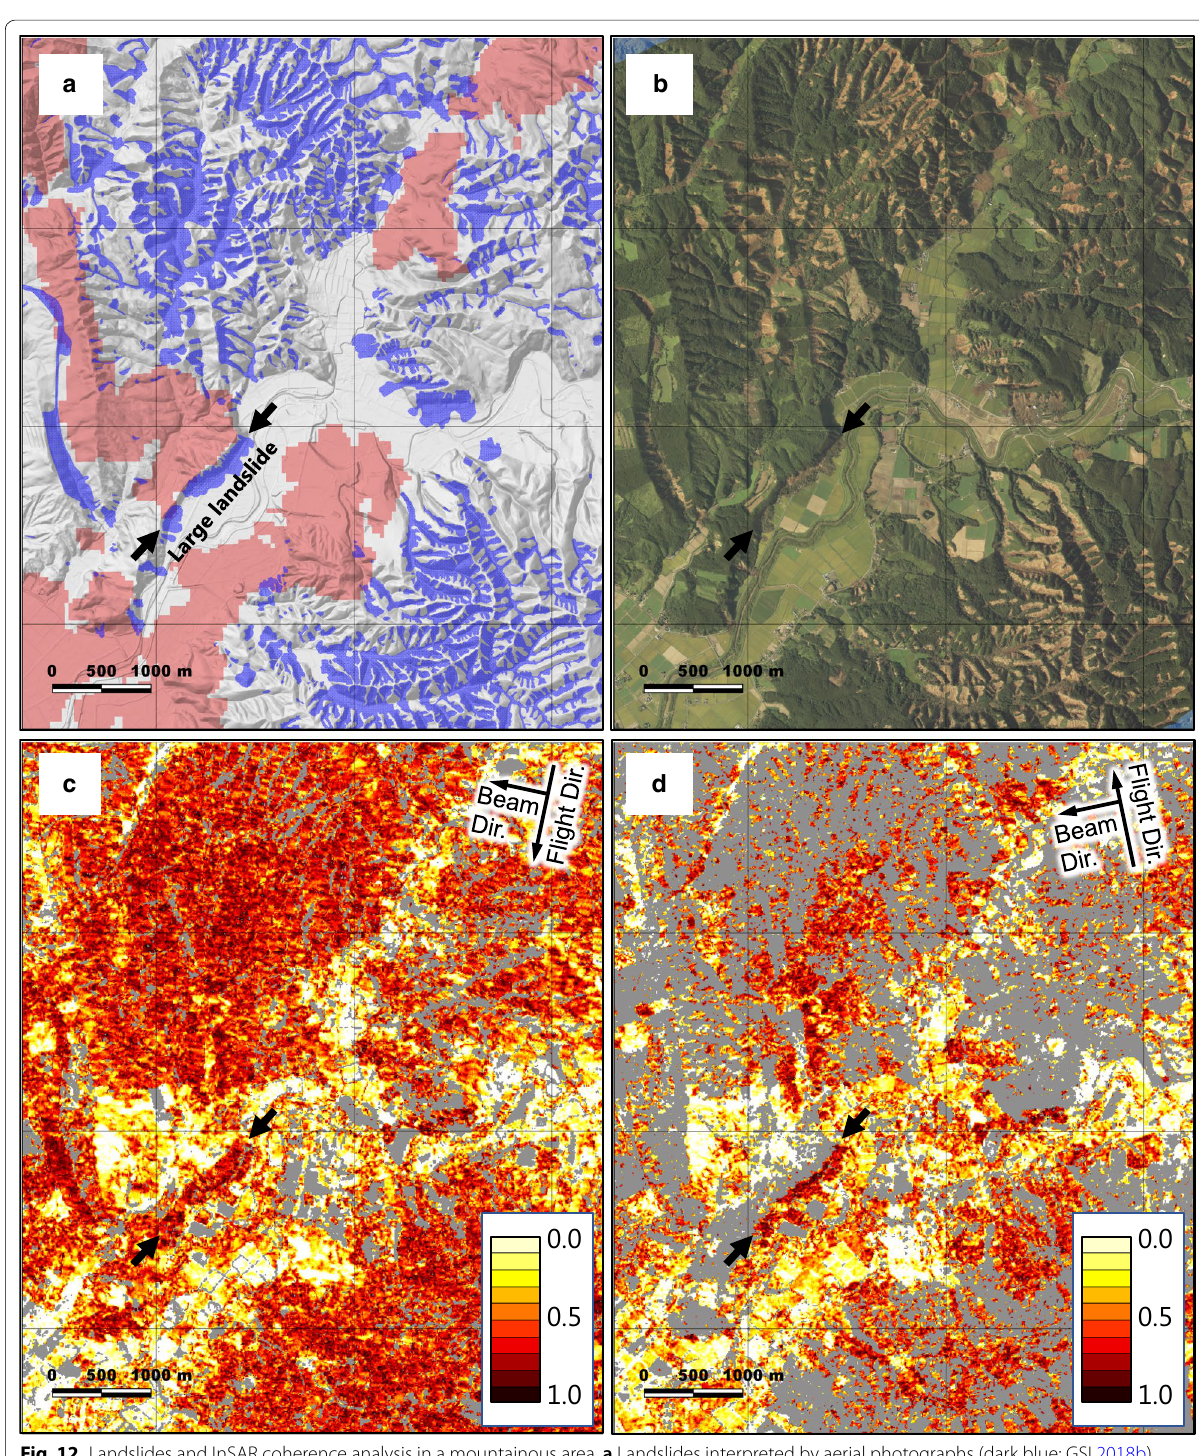
Fig. 12 Landslides and InSAR coherence analysis in a mountainous area. a Landslides interpreted by aerial photographs (dark blue; GSI 2018b) on shaded relief map; location shown in Fig. 11. Pink indicates areas where the normalized phase noise deviation was small enough for the phase unwrapping in Figs. 5 and 6. Black arrows indicated the location of a large landslide that caused the collapse of many houses. b Aerial photograph from after the earthquake. Black arrows are the same as in a . c Normalized coherence change of SAR image pairs 1 and 3. Gray shading indicates masked areas where the coherence before the earthquake was < 0.2. Black arrows are the same as in a . d Normalized coherence change of SAR image pairs 2 and 4. Gray shading indicates masked areas where the coherence before the earthquake was < 0.2. Black arrows are the same as in